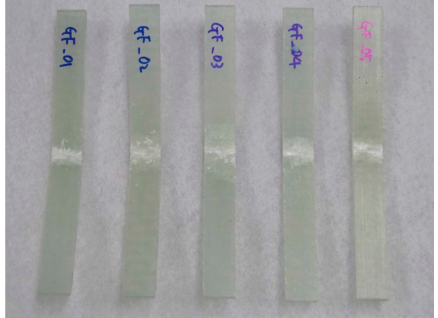
Figure 5. Fracture shape of flexural specimen.